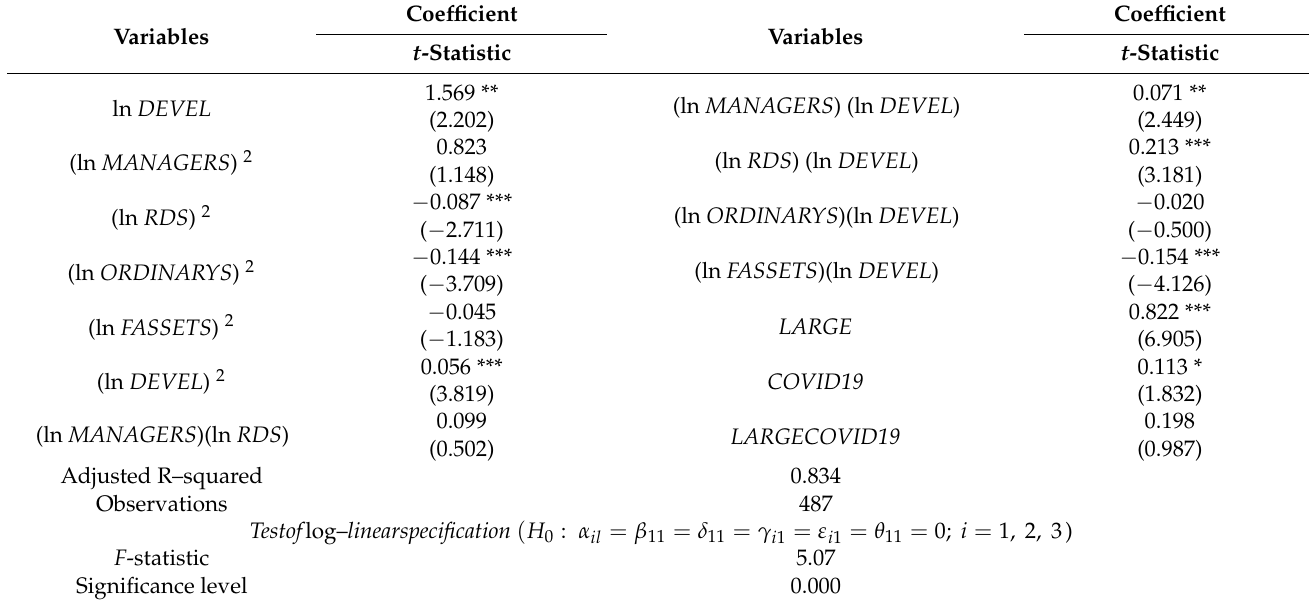
Table 4. Coefficient estimates for variables in this study ( t –statistics in parentheses).